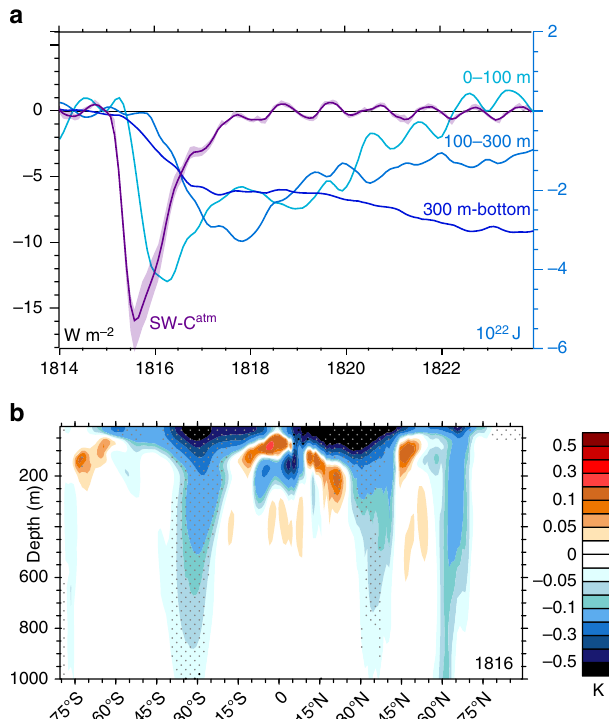
Fig. 6 Responses in OHC with depth to the 1815 eruption. a Evolution of SW-C atm (left axis) and OHC (right axis) across various ocean layers. b Anomalies in zonal mean ocean temperature by depth and latitude in 1816, with stippled regions indicating a consistent sign of anomalies across at least 14 of the 18 (80%) ensemble members. Shading in a denotes the range of two standard errors. Years indicated on the abscissas begin at the corresponding tick marks